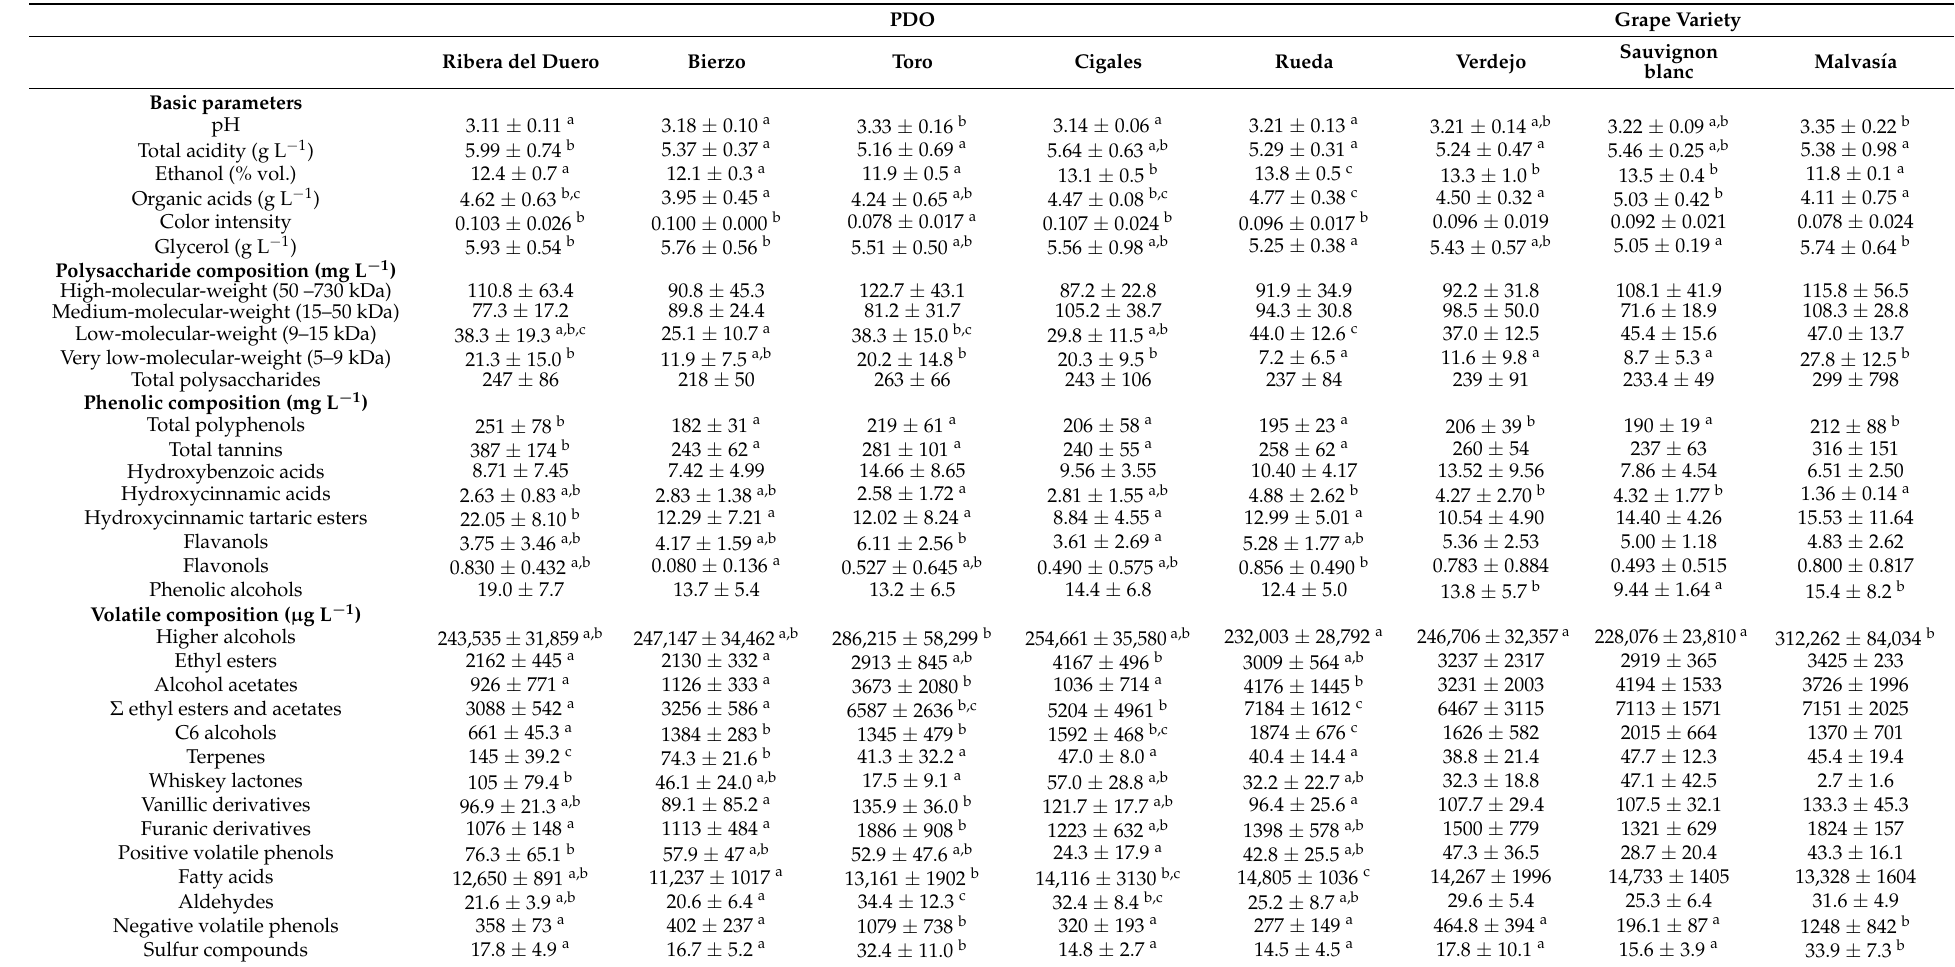
Table 2. Classic enological parameters, color intensity, organic acids, glycerol, phenolic and volatile content of PDO white wines. PDO Grape Variety Ribera del Duero Bierzo Toro Cigales Rueda Verdejo Malvas í